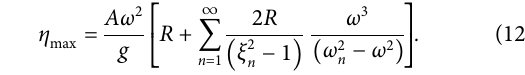
Frontiers in Materials |